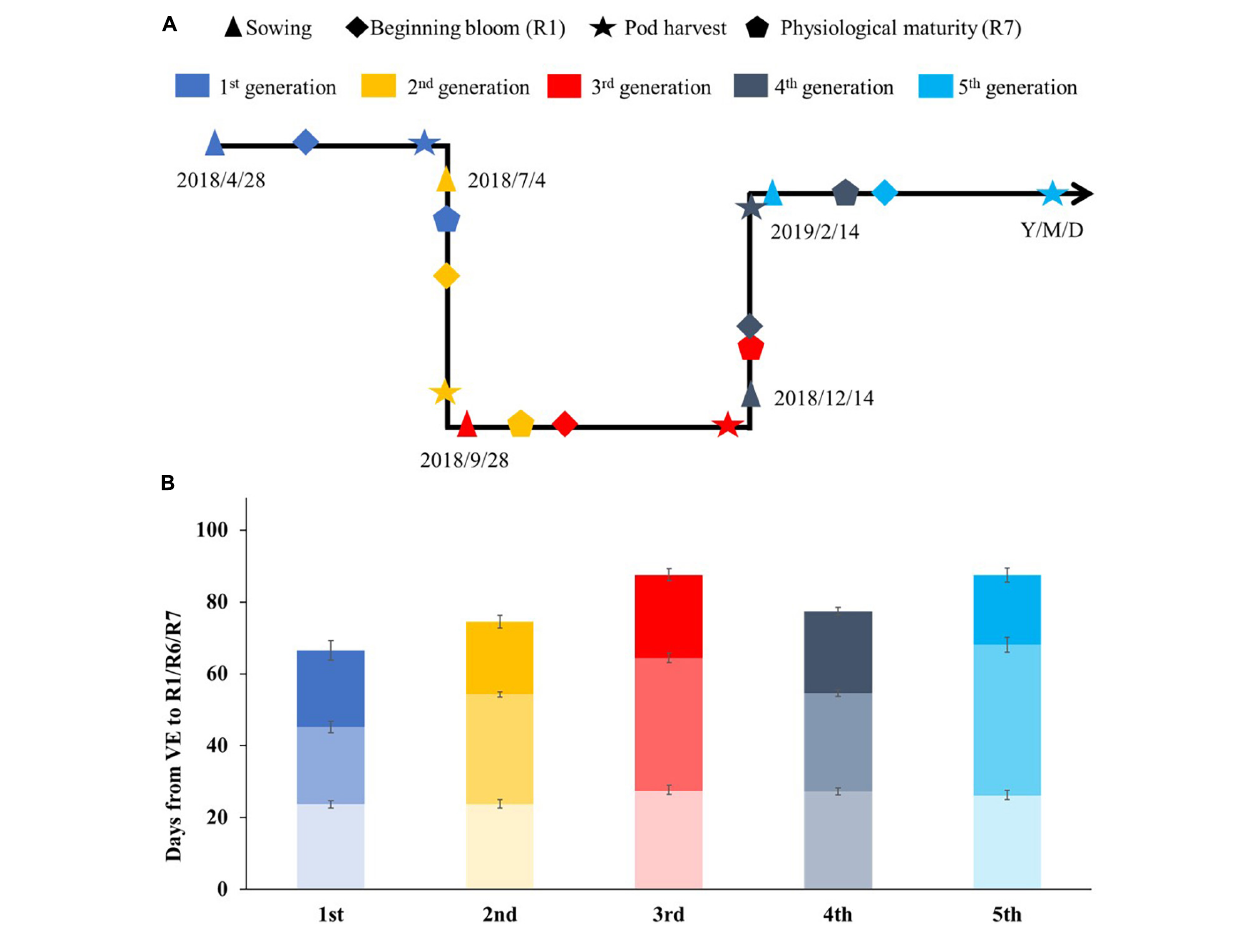
FIGURE 3 | The growth periods of soybean cv . Heihe27 under natural conditions (May to October) and glasshouse (November to April) in Beijing, 2018–2019. (A) Timeline of soybean development during summer nursery in Beijing and Hainan. (B) Developmental stages of Heihe27 planted in Beijing. VE, emergence; R1, beginning bloom; R7, beginning